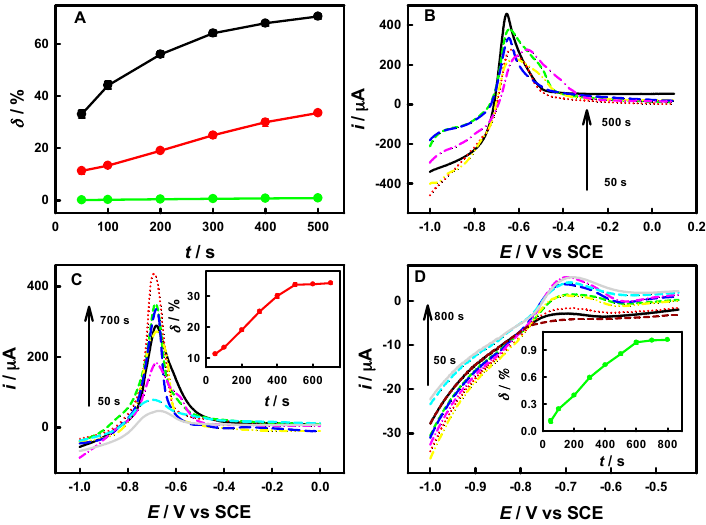
Figure 1. δ versus preconcentration-time curves ( A , and Insets of C and D , n = 3) and anodic stripping LSV curves of the CdS QDs cast-coated on GCE (B, C and D, 100 mV·s − 1 ) for our protocol ( B ), the similar protocol but without the beforehand exertion of a cathodic potential in air ( C ), and conventional solution-replacement protocol ( D ). Ten microliters of 10-fold diluted 6.5 mM CdS QDs dispersion was used for cast coating.